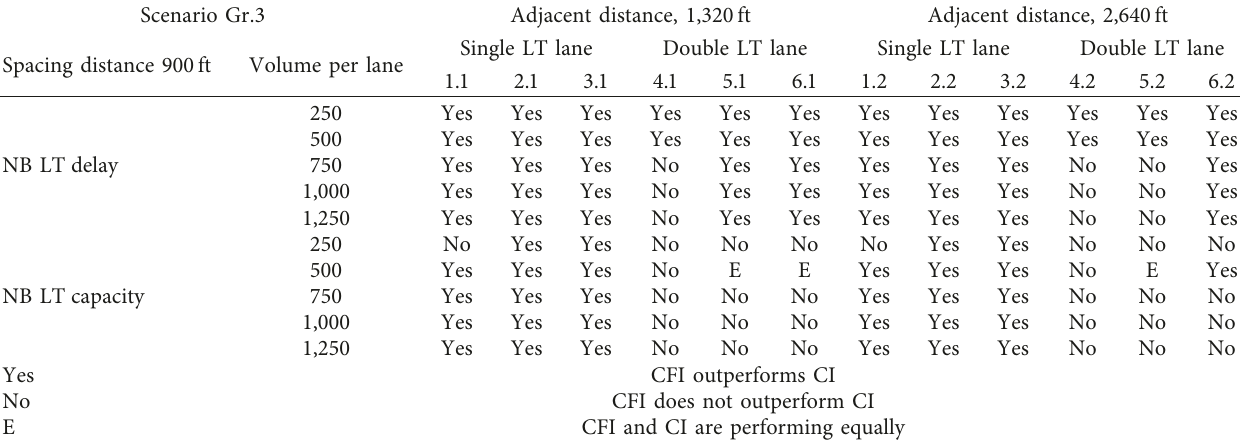
Table 3: Scenario group 1 results.